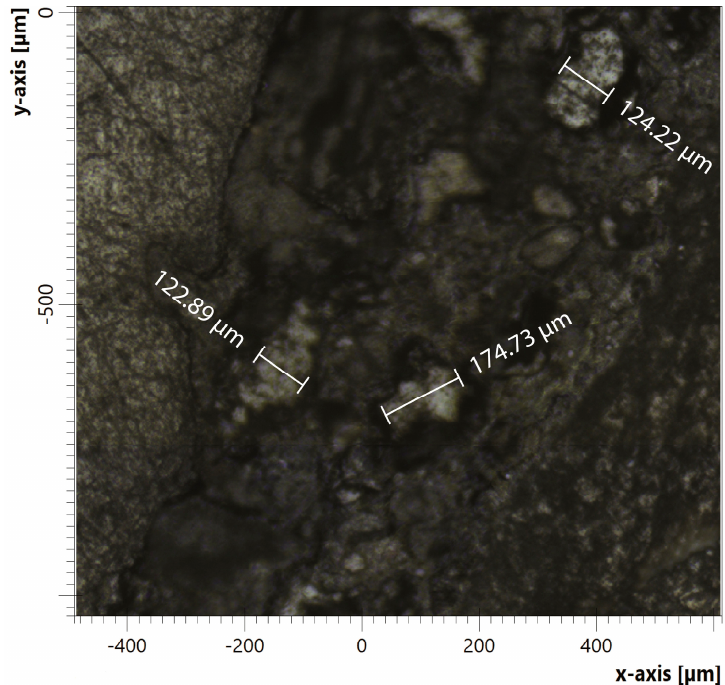
Figure 14. Bituminous mortar as coating of a RA granulate.